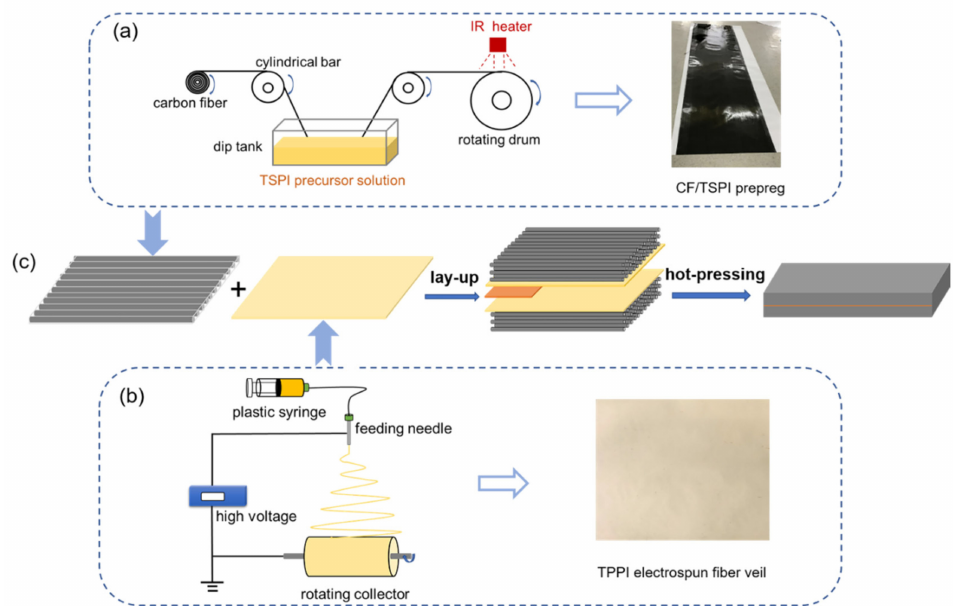
Figure 1. The process schematic of ( a ) preparation of unidirectional CF/TSPI prepreg; ( b ) electrospinning of TPPI fiber veil; ( c ) preparation of TPPI fiber veils interleaved CF/TSPI